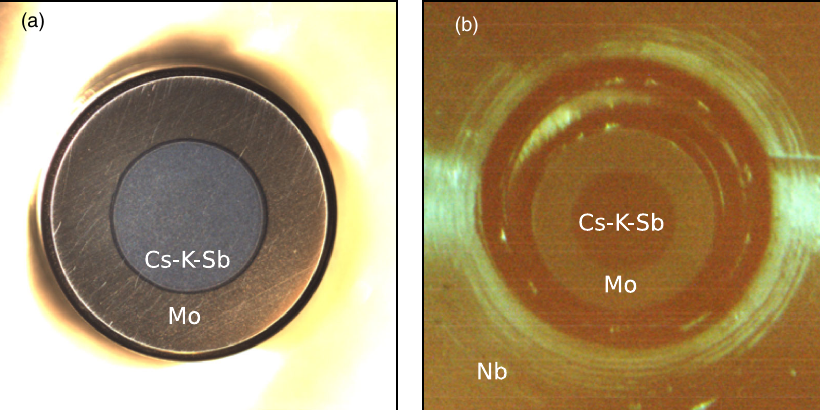
FIG. 8. Images of G002 taken (a) after growth in the preparation chamber and (b) after transfer into the SRF